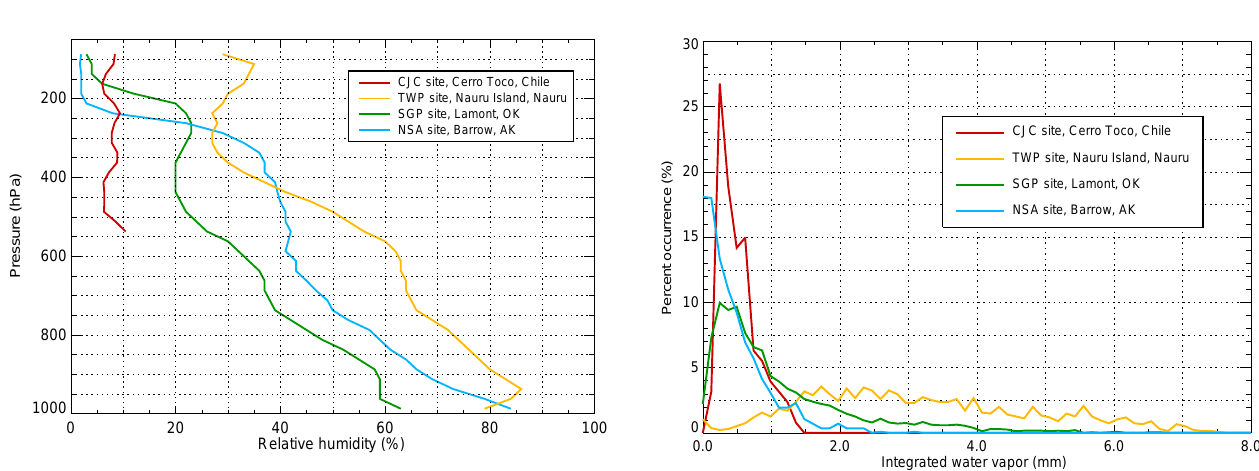
Figure 8. Distributions of upper-tropospheric integrated water va- por (IWV) from 530 to 200hPa for four ARM sites, each with dis- tinct climates. The mean surface pressure at the CJC site is 530hPa, while 200hPa is the approximate height of the